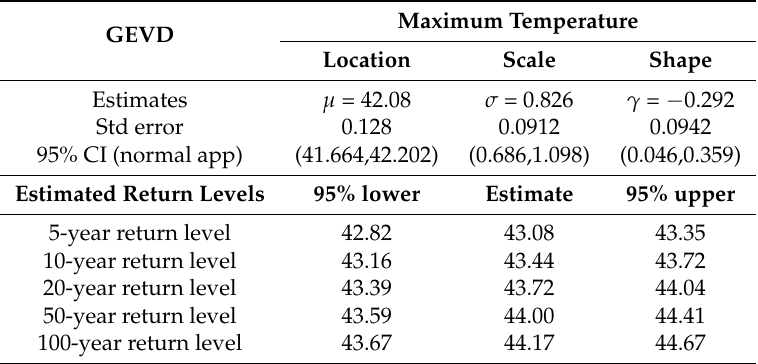
Table 6. GEVD estimates of maximum temperature.